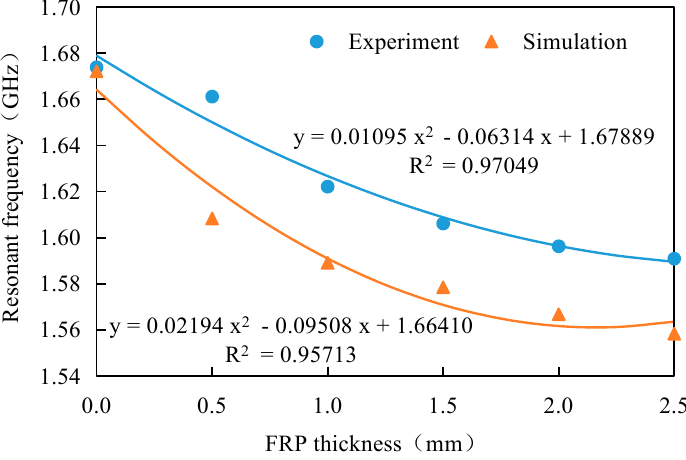
Figure 13. Effects of FRP thickness on resonant frequency.